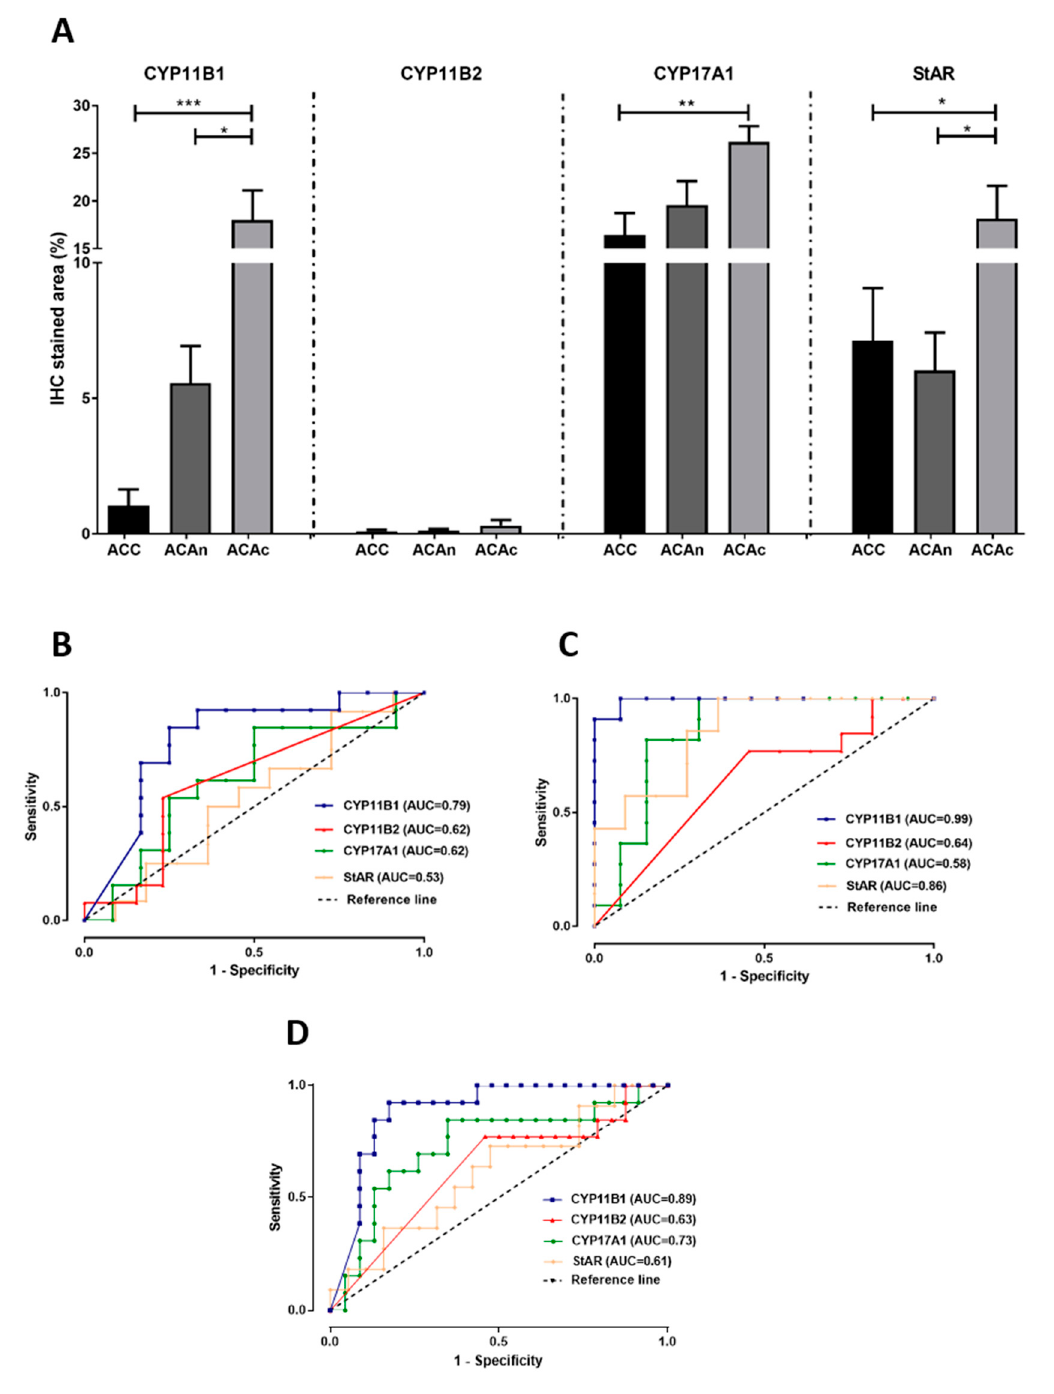
Figure 3. Graphical representation of the percentage of CYP11B1, CYP11B2, CYP17A1 and StAR expression in the studied groups ( A ). ROC curves to distinguish adrenocortical carcinomas (ACC) from non-functioning adrenocortical adenomas (ACAn) ( B ); ACC from adenomas with Cushing’s syndrome (ACAc) ( C ); and ACC from total adenomas ( D ) with the respective area under the curve (AUC). * p < 0.05; ** p < 0.01; *** p < 0.001; dashed lines represent the reference lines of the ROC curves.